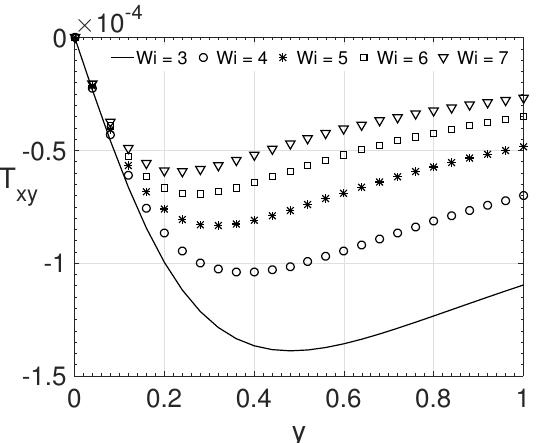
Figure 13. Wi influence on the wall-normal variation y of the extra-stress tensor component T xy . Dimensionless parameters: Re = 1000, β = 0.5, (cid:101) = 0.25 and ξ =